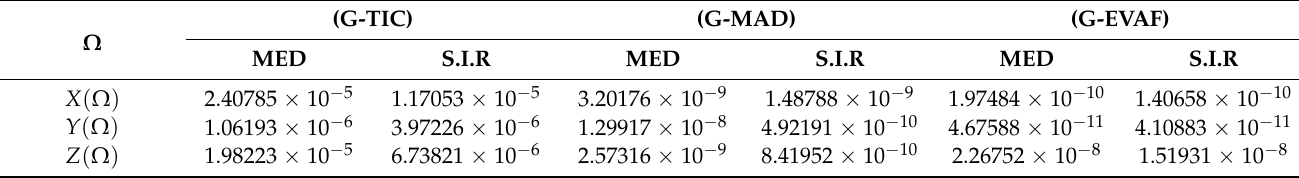
Table 5. Global measures performances of the environmental and economic nonlinear